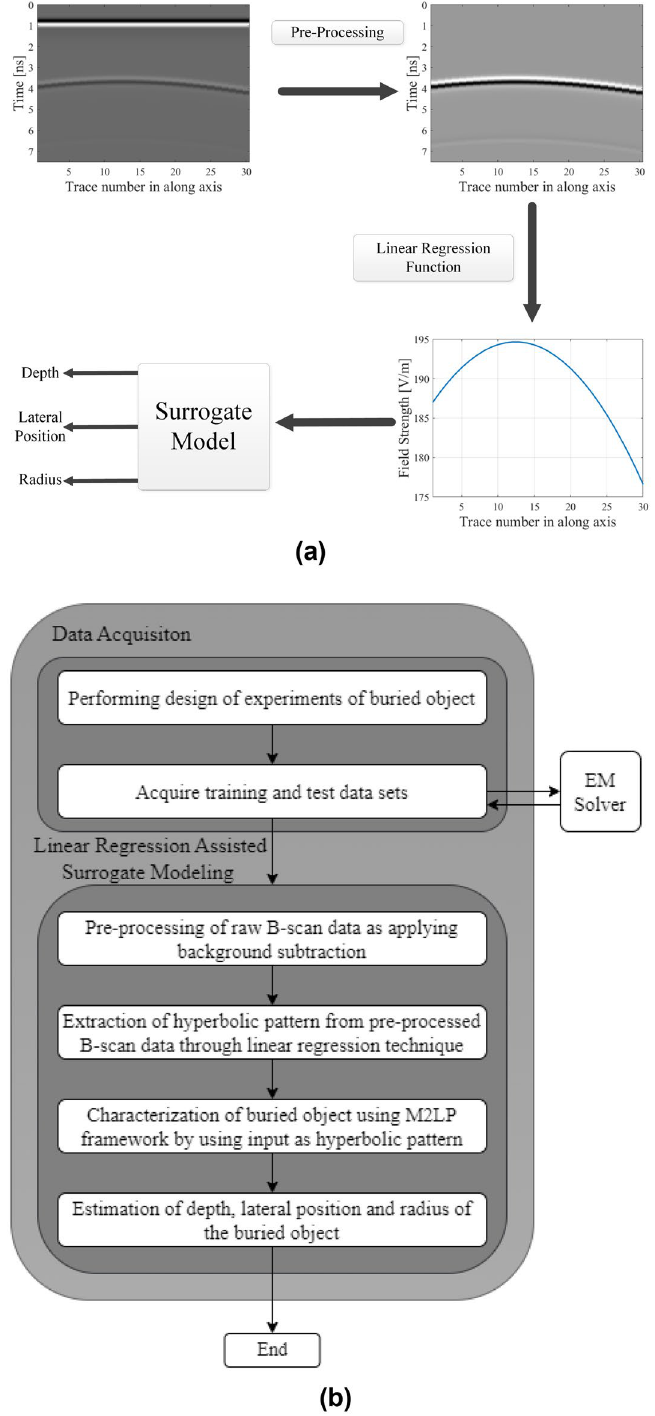
Figure 7. Modeling framework: ( a ) inputs and outputs of the phases in linear regression assisted surrogate modeling, ( b ) flowchart of the proposed data driven surrogate model for buried object